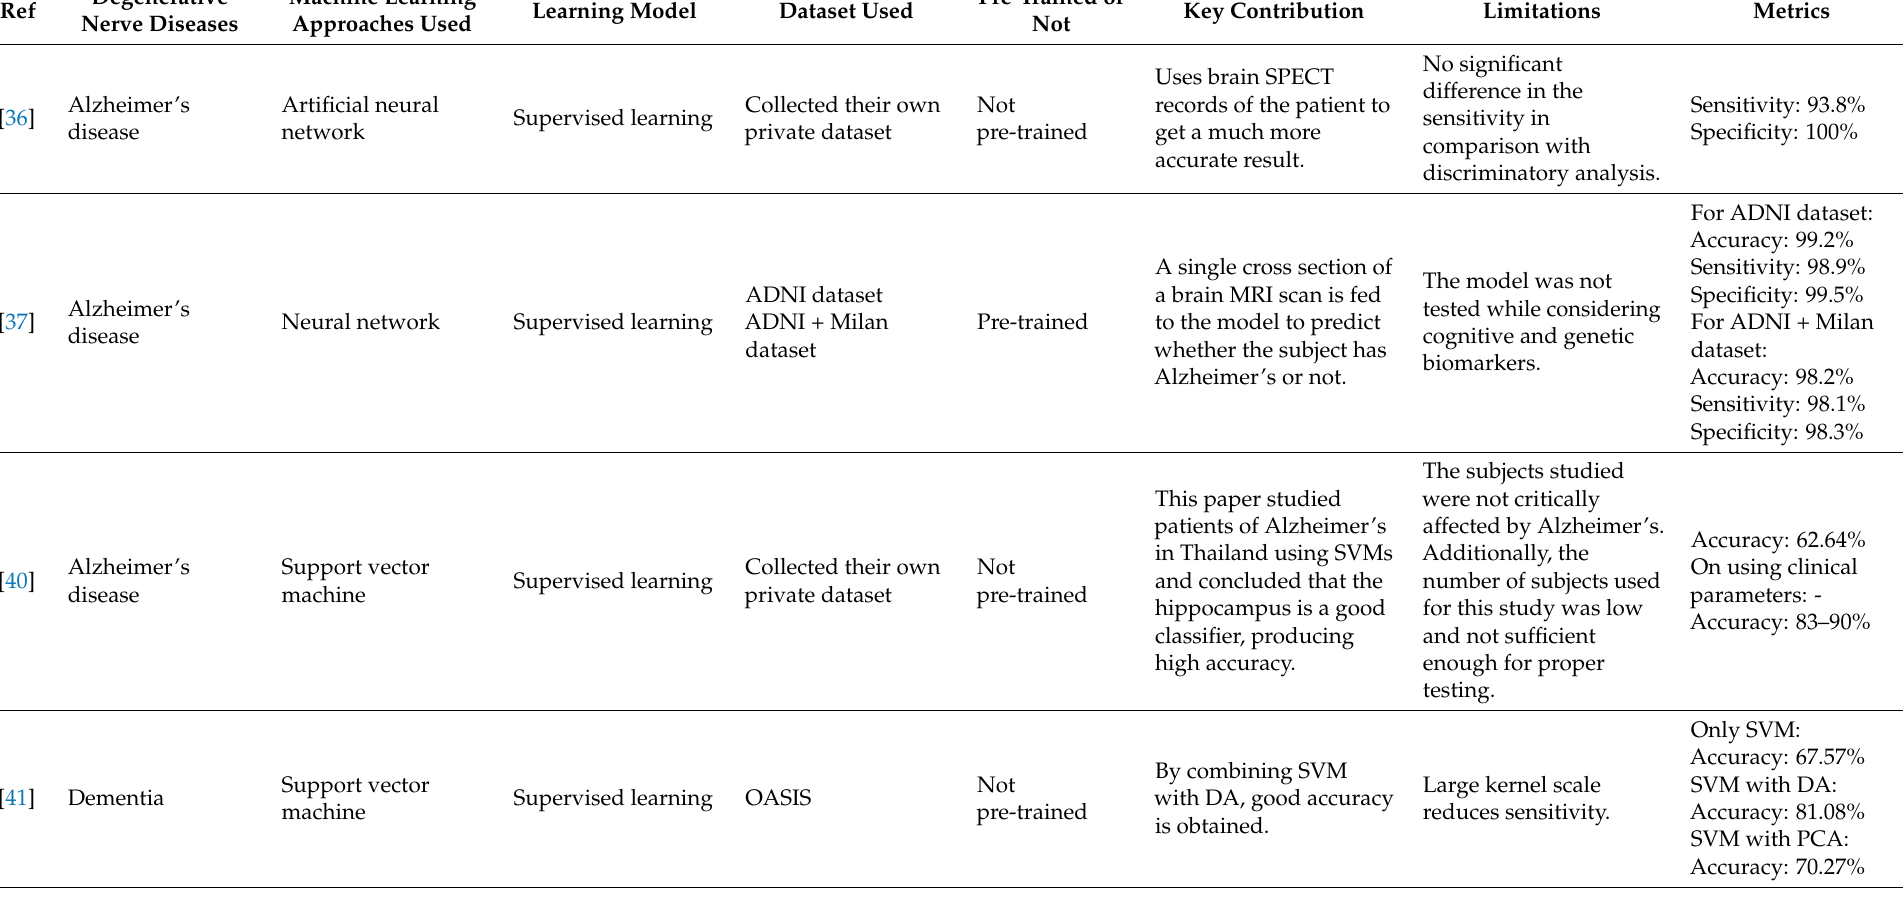
Table 1. A summary of works on machine learning for degenerative nerve disease